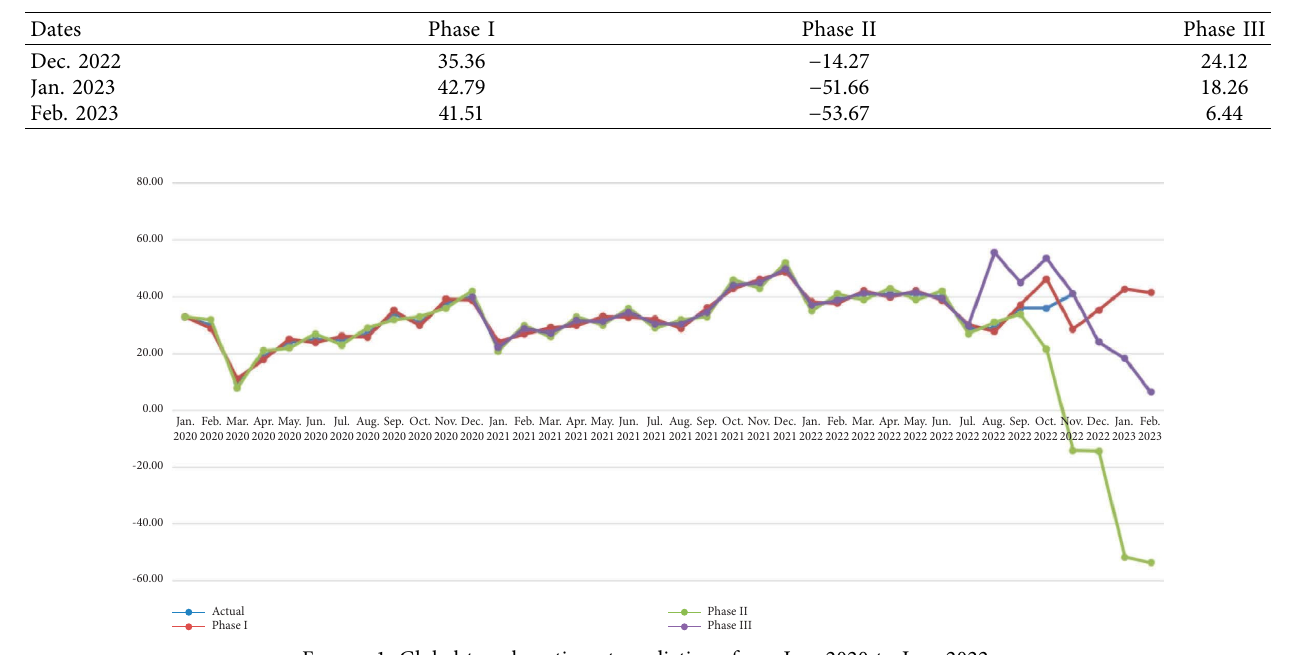
Table 4: Predicted travel sentiment in diferent countries.